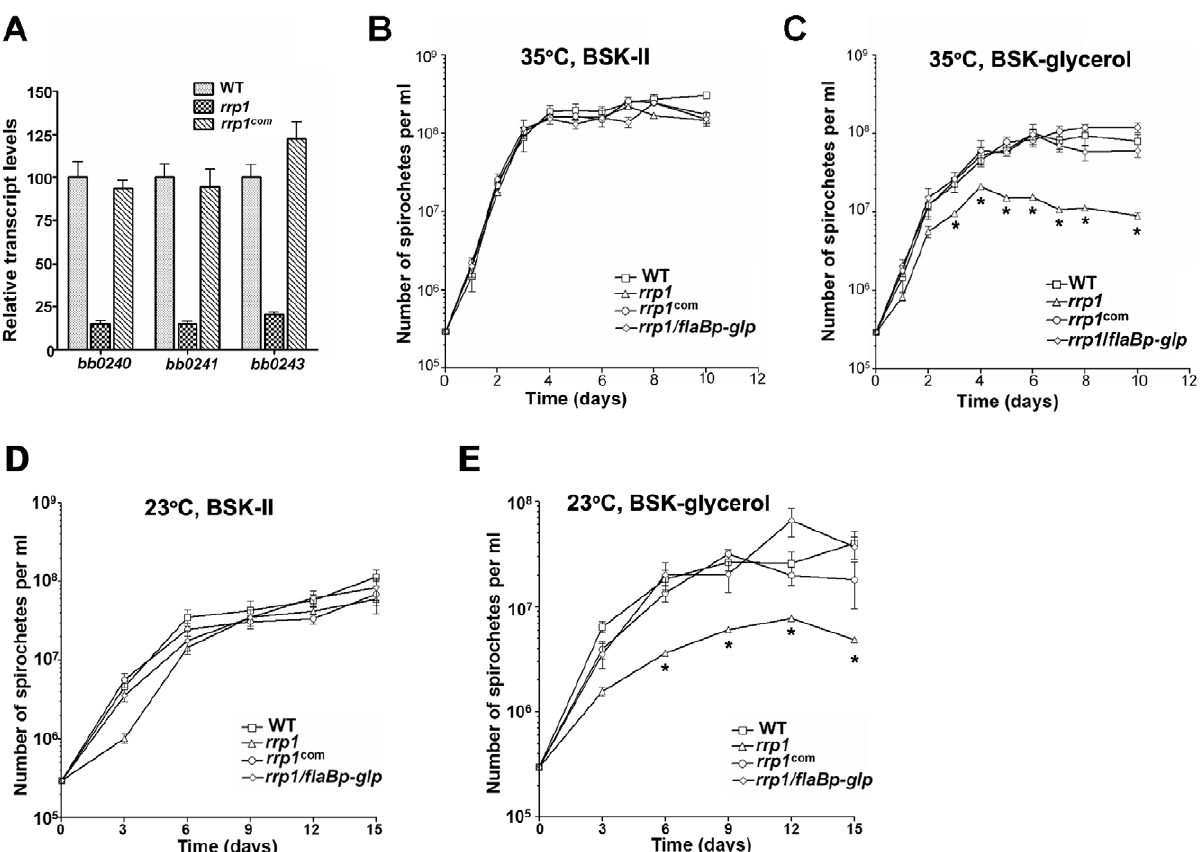
Figure 4. Rrp1 controls expression of the glycerol gene operon ( bb0240-0243) . ( A ) Relative transcript levels of the glycerol operon glp ( bb0240-bb0243 ) in wild-type, rrp1 , and rrp1 com by real-time RT-PCR. RNA was isolated from late logarithmic phase cultures grown at 35 u C in standard BSK-II medium. Values represent the average copy number for each gene ( 6 standard deviation) normalized per 1000 copies of flaB. ( B–E ) growth curves of wild-type, rrp1 , rrp1 com or rrp1/flaBp-glp at 23 u C ( D, E ) or 35 u C ( B, C ) in standard BSK-II medium ( B, D ) or BSK-glycerol medium ( C, E ). The initial cell density was 3 6 10 5 cells/ml for each strain. Spirochetes were enumerated under dark-field microscopy. Data presented here is from one representative experiment with three independent cultures. Each data point was the average of data from three independent cultures. *, P ,